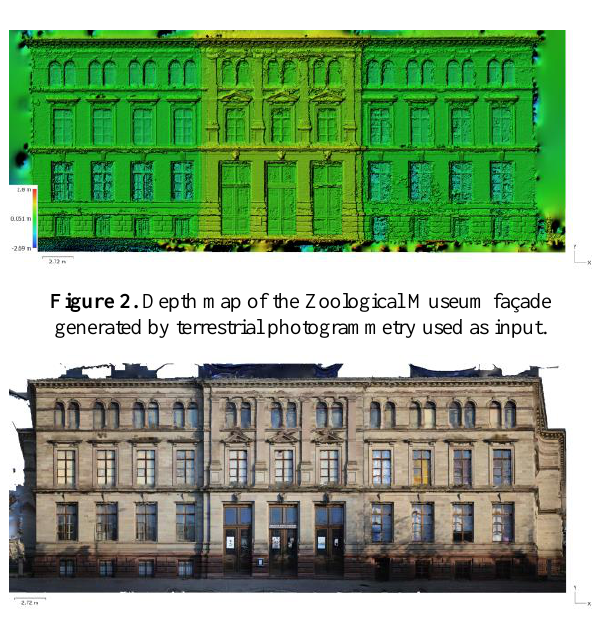
Figure 3. Corresponding orthophoto to the depth map in Figure 2 created also from photogrammetry.